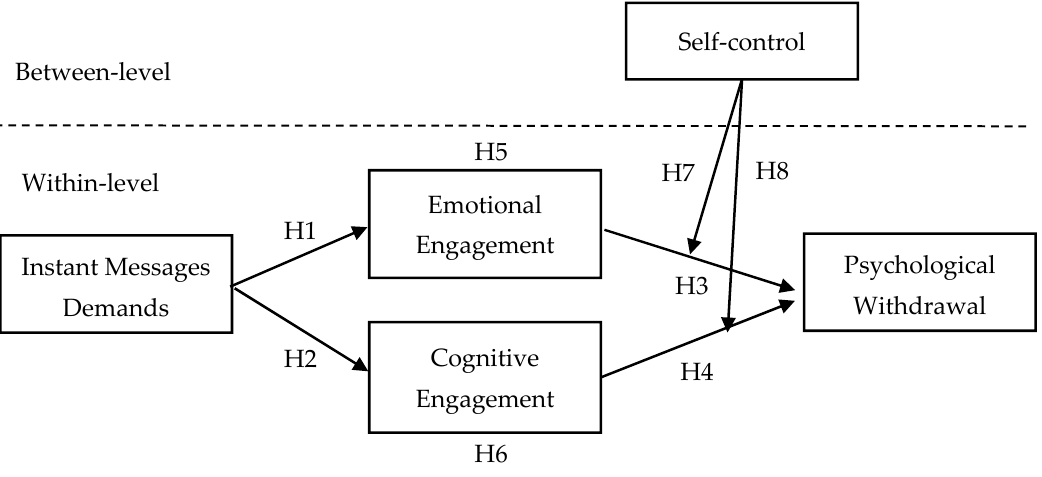
Figure 1. Theoretical model.